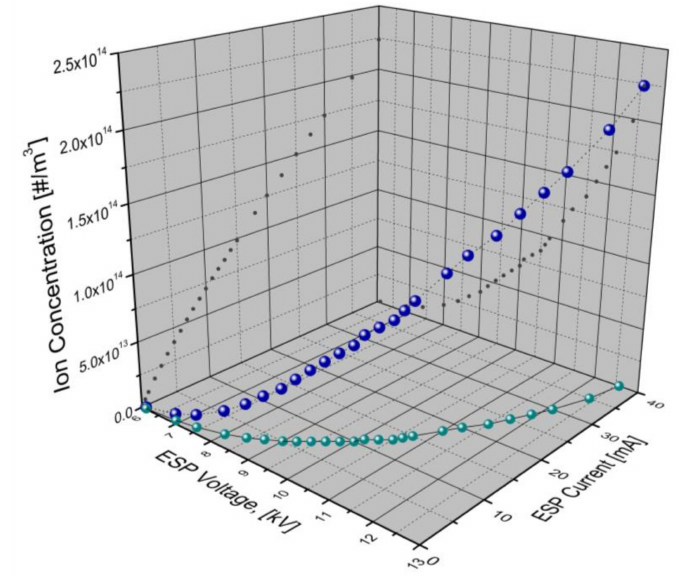
Figure 3. The ESP current–voltage and ion concentration